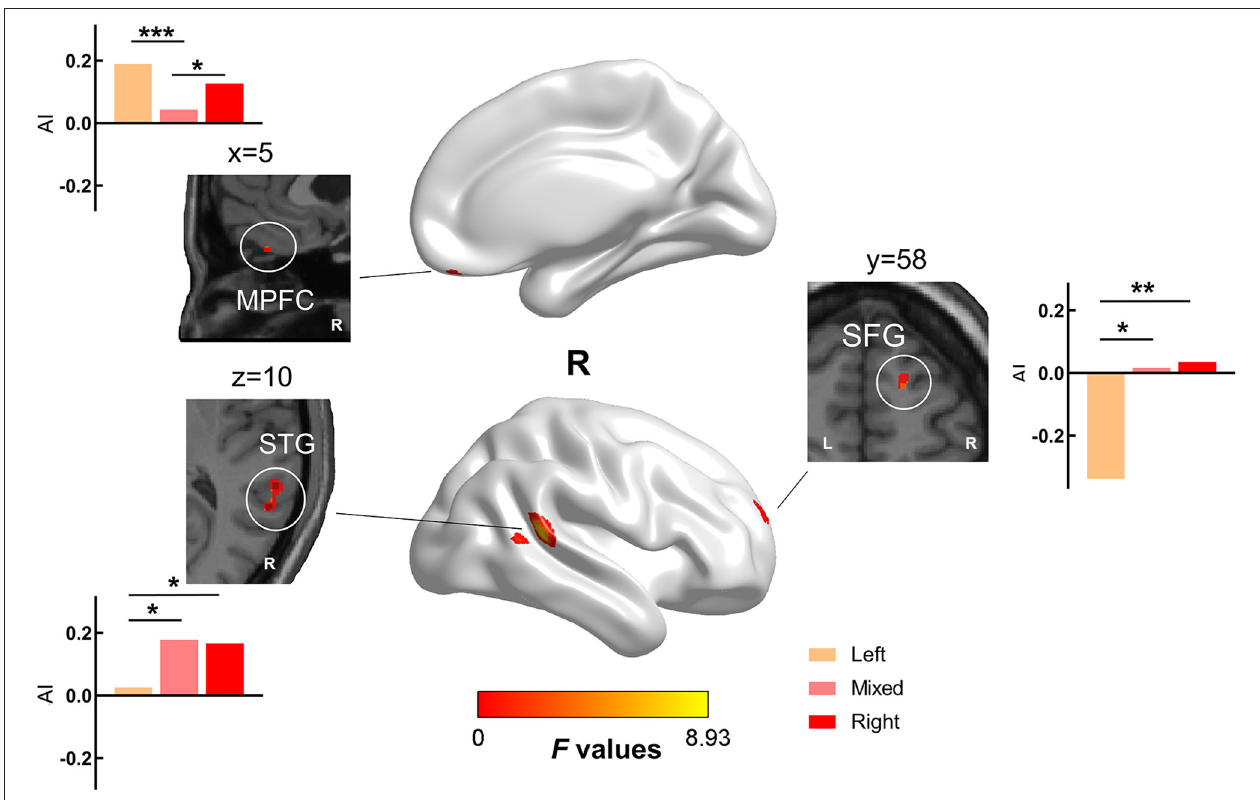
FIGURE 2 | Brain areas with significant differences in AI values among the three groups. There were significant differences in gray matter lateralization in the medial prefrontal cortex (MPFC), superior frontal gyrus (SFG), and superior temporal gyrus (STG) among the three groups. (FWE cluster corrected, p < 0.050). We extracted the AI values of the above significant clusters and performed post-hoc analysis to determine the differences between the two groups. We found that LH and RH showed a rightward shift of gray matter compared with MH in MPFC, and LH showed a leftward shift in SFG and STG compared with mixed/RH. (*: p < 0.050, **: p < 0.010, ***: p < 0.001).